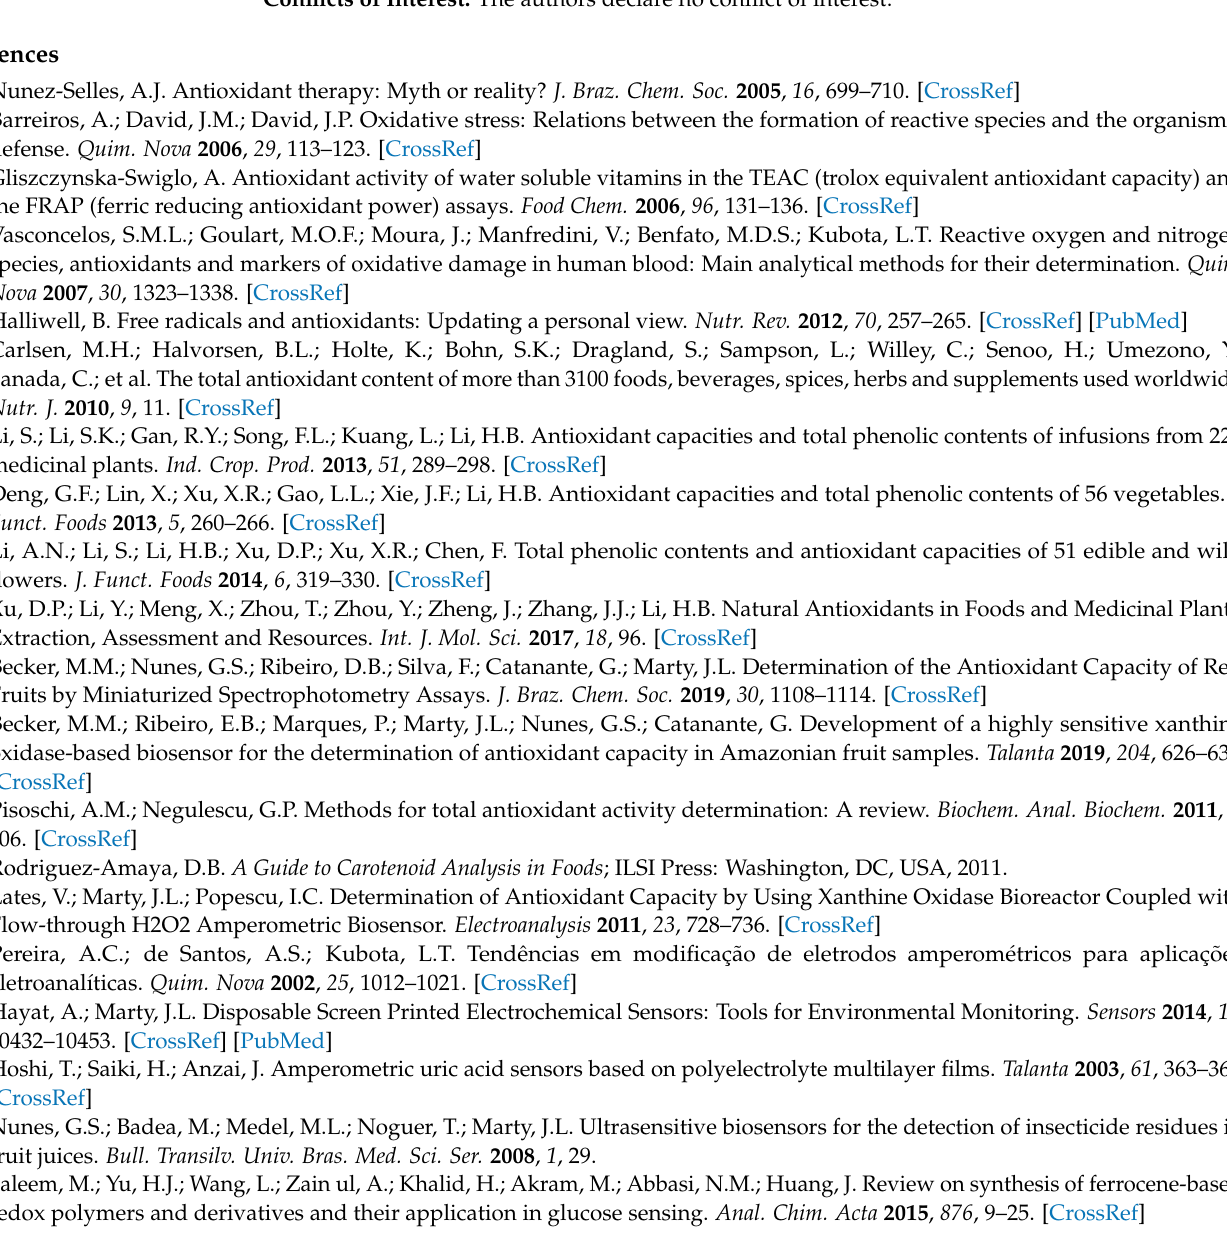
Figure S4: Distribution of the references concerning antioxidant capacity detection, according research area—since 1997; Figure S5: H-index related to the ISI WOS references dealing with antioxidant capacity detection—since